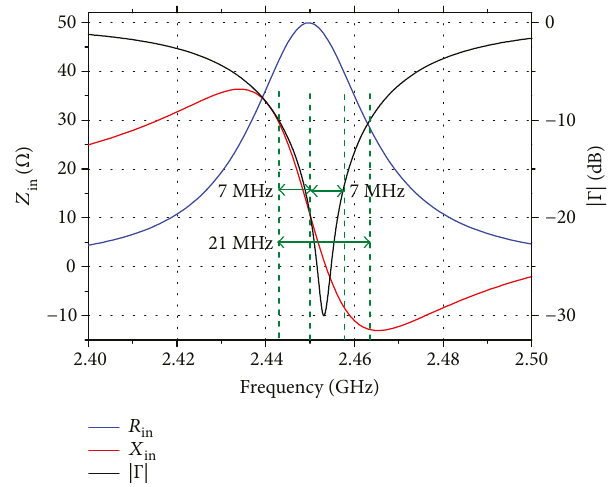
Figure 4: HB input impedance and re fl ection coe ffi cient module. 2